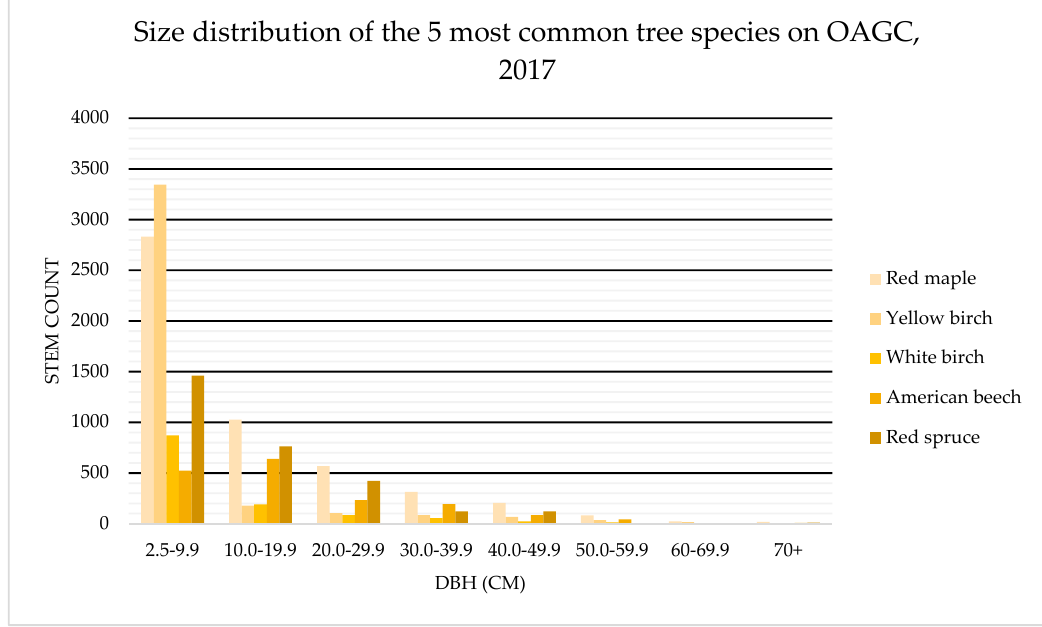
Figure 9. Size distribution of the five most commonly occurring species (based on plot projections) on OAGC in 2017. The abundance of small-stemmed Yellow birch and Red maple (as opposed to Pin cherry, White birch, or Trembling aspen) suggest that the forest is moving into a more mature phase.